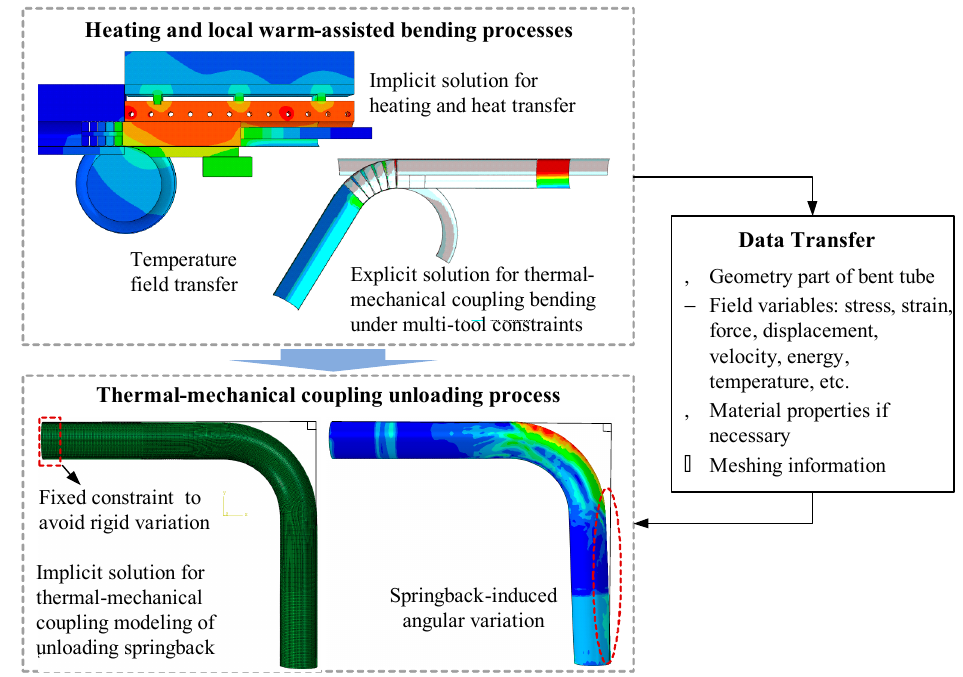
Figure 4. Flowchart for coupled thermal-mechanical modeling of springback.